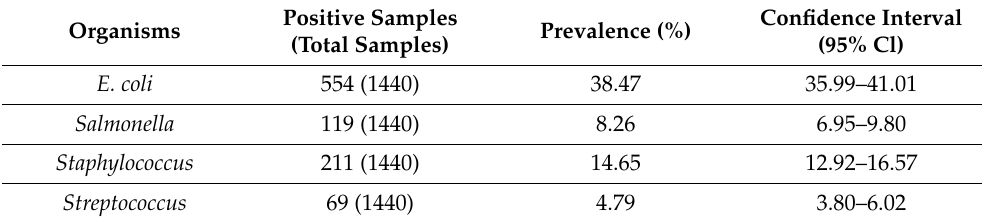
Table 1. Prevalence of AMR pathogens in livestock-source food products and by-products.